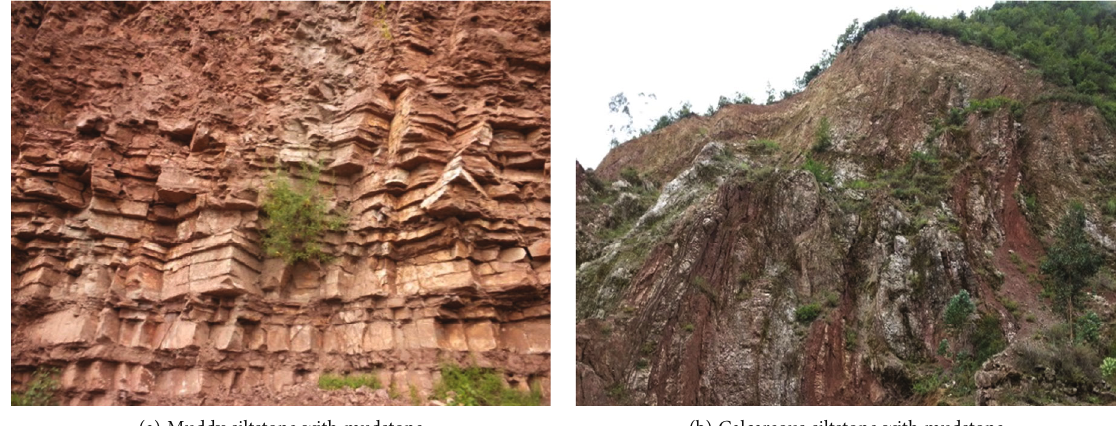
Figure 4: Intercalated mudstone-type stratigraphic structure.